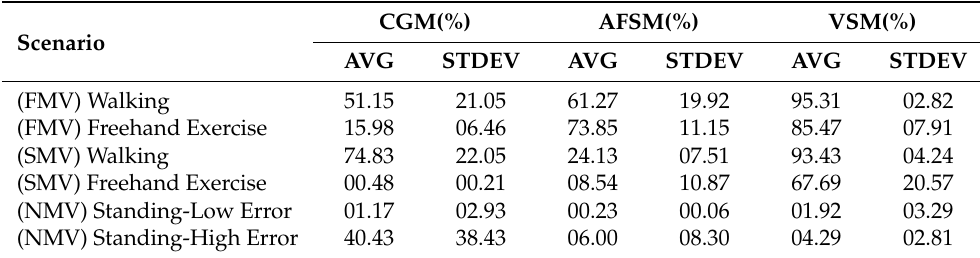
Table 3. Experiment 1 result for movement scenarios. Each cell represents (average detection rate, standard deviation) through prepared 15 video sequences. Detection rate is calculated by (number of frame which method returned ‘moved’)/(number of total frame) in every single video sequence. Units of measure are percentage.